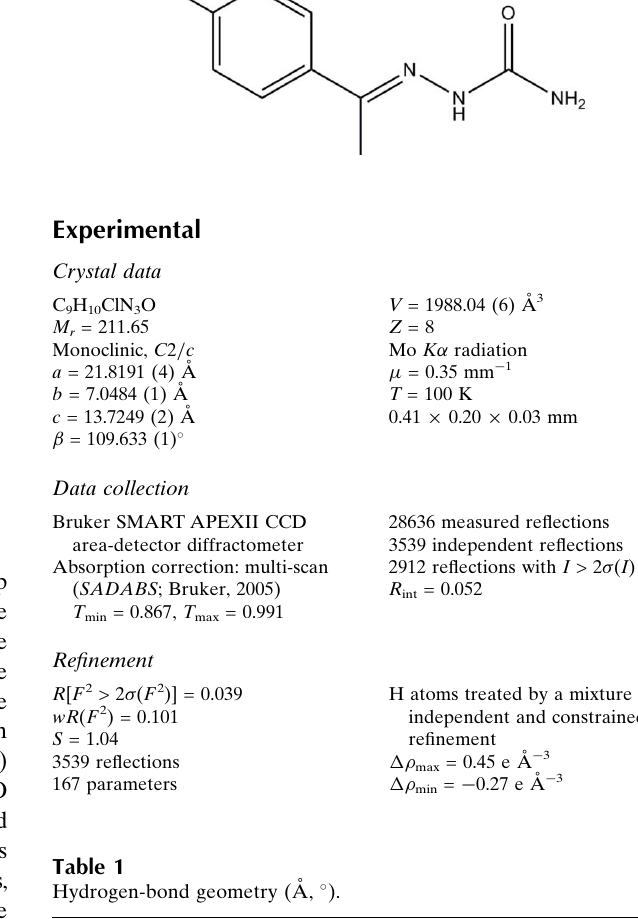
Hydrogen-bond geometry (A˚ , (cid:2) ). D —H (cid:3)(cid:3)(cid:3) A